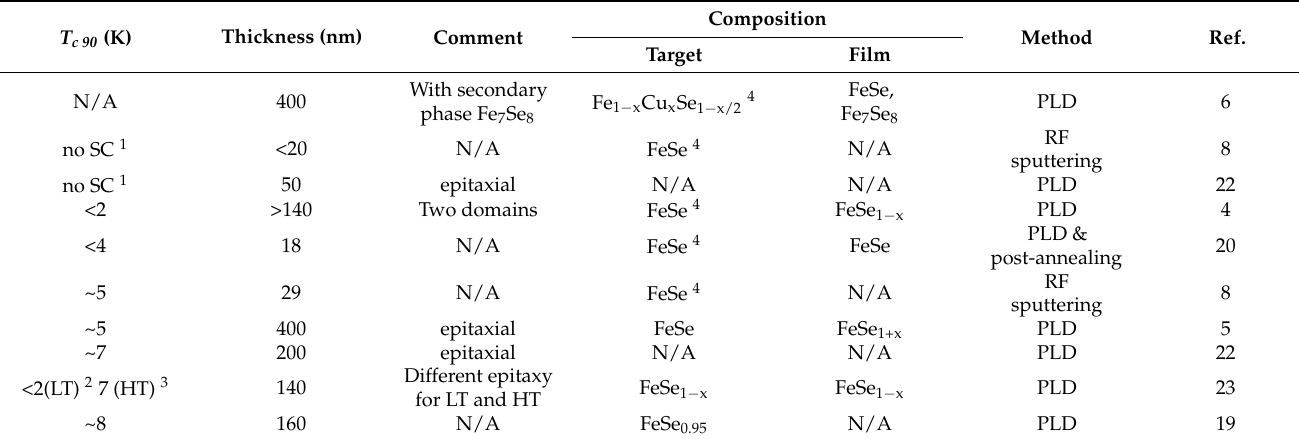
Table 1. Relevant literature for growth of FeSe/MgO